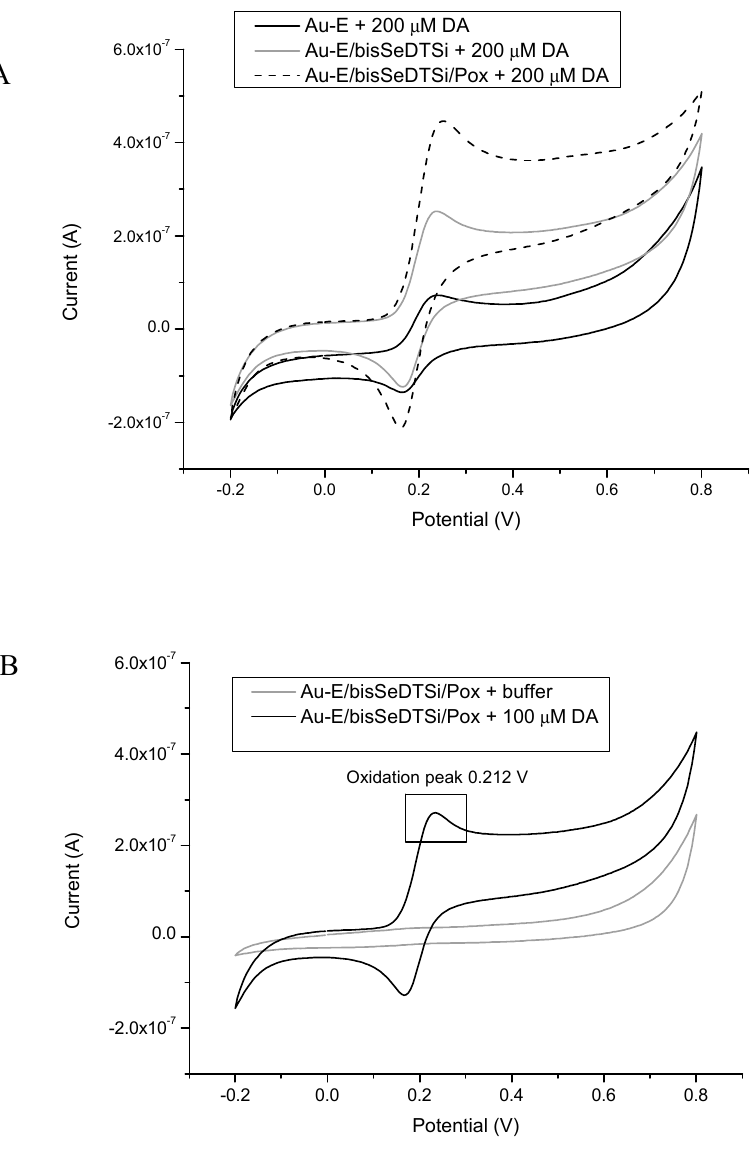
Figure 11. ( A ) Representative CV scans of the bare Au electrode (1), Au electrode modified with bisSeDTSi (2), and Au-E/BisSeDTSi/Pox (3) system in the presence of DA (200 μ M) under an applied potential in the range of − 0.2 to 0.8 V, scan rate 50 mV/s, versus Ag/AgCl (0.1 M). ( B ) Detection system for Au-E/BisSeDTSi/Pox with and without the investigated sample (DA).